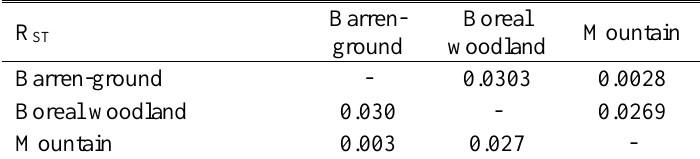
Table A2.3. Pairwise R ST values based on microsatellites for the three major groups identified by structure analysis (below diagonal) and pairwise P values (above diagonal).